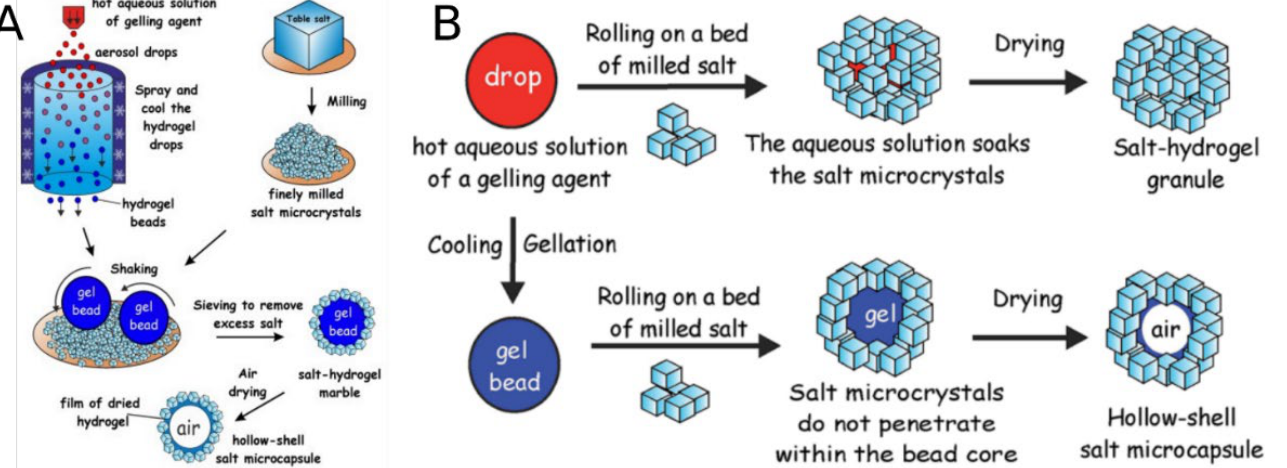
Figure 1. ( A ) Salt–hydrogel marbles and hollow-shell particle production; ( B ) Possible outcomes in the fabrication of salt marbles. Reproduced from Ref. [69] with permission from the Royal Society of Chemistry.